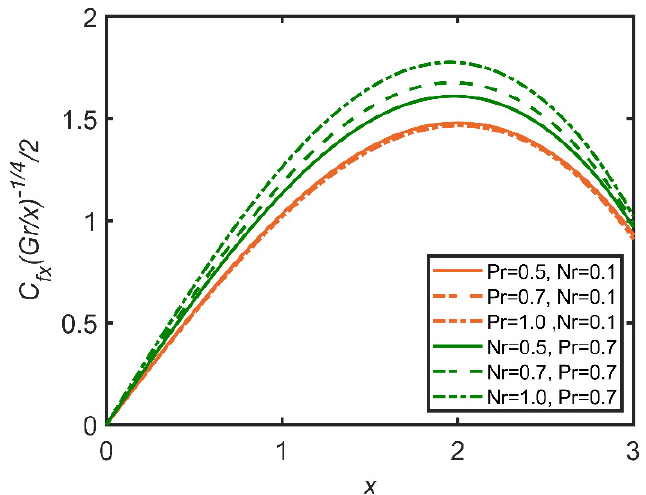
Figure 9. Comparison for skin friction against x.